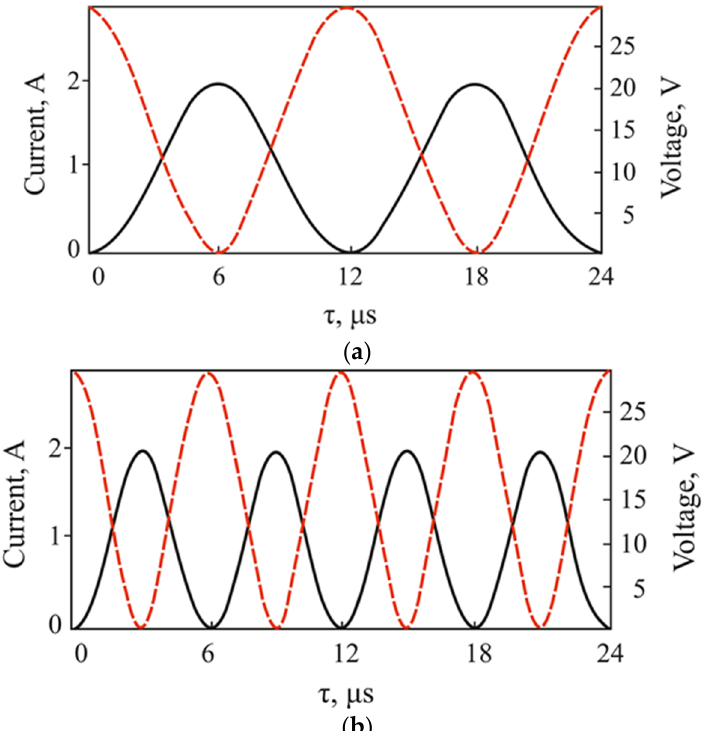
Figure 6. Typical graphs of discharge current (solid curves) and voltage (dashed curves) oscillations: ( a ) at P He = 5 Torr; ( b ) at P He = 10 Torr.